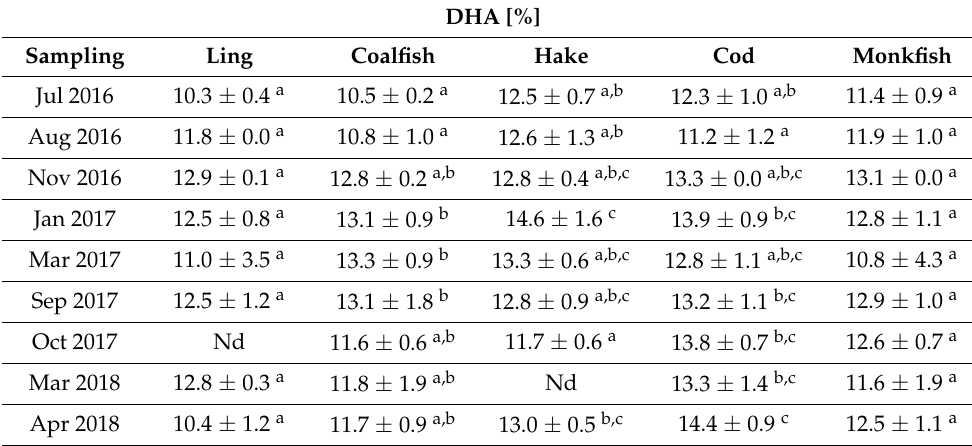
Refer to Table 1 for the number of livers sampled for each species at each time point. Values in the same column with the same letter a, b... are not significantly different. Nd is not